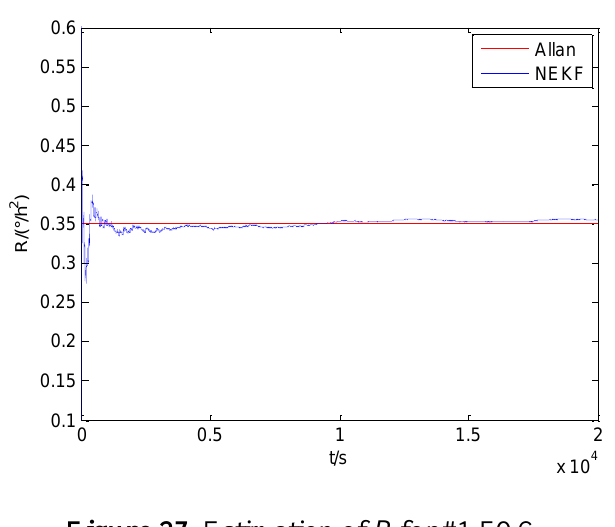
Figure 26. Estimation of K for #1 FOG.